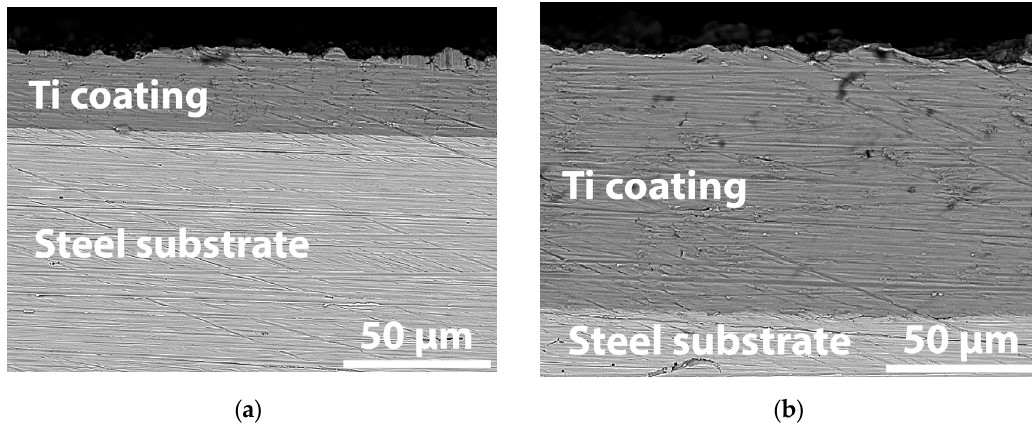
Figure 2. Cross-section SEM images of the samples with Ti coatings: 20 µm ( a ); 80 µm ( b ).